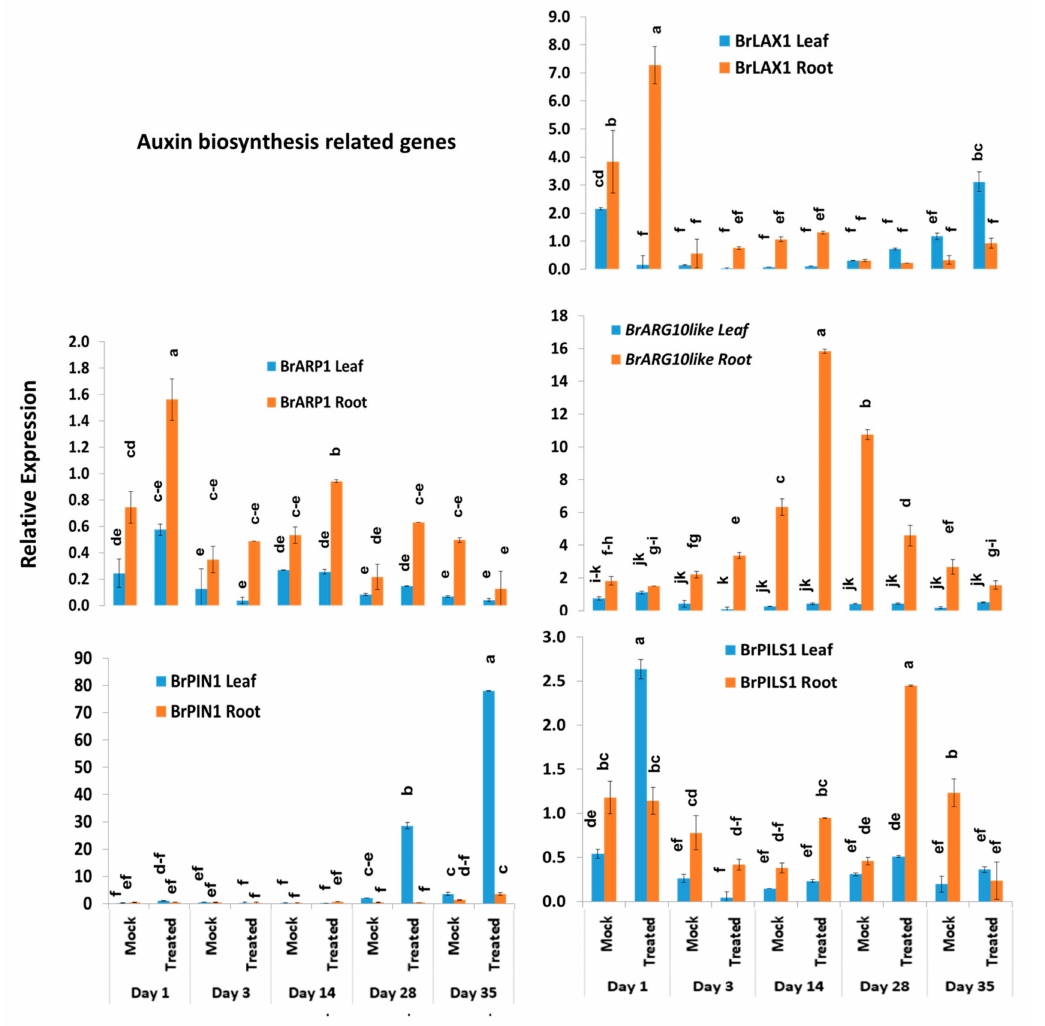
Figure 7. Variation in the relative expression levels of other auxin-related genes in leaf and root samples under di ff erent treatment × time-point combinations: Data represent relative expression levels of three di ff erent treatment types—sample type (leaf vs. root), treatment (Seosan-inoculated vs. mock-treated), and time-points. Vertical bars represent standard deviation. Each data point estimates the average of three independent biological replicates. Data bars separated by di ff erent letters indicate the 5% statistical significance level according to Tukey’s pairwise comparisons. Expression of genes in leaf tissues of control (nontreated) plants on day 0 were set to